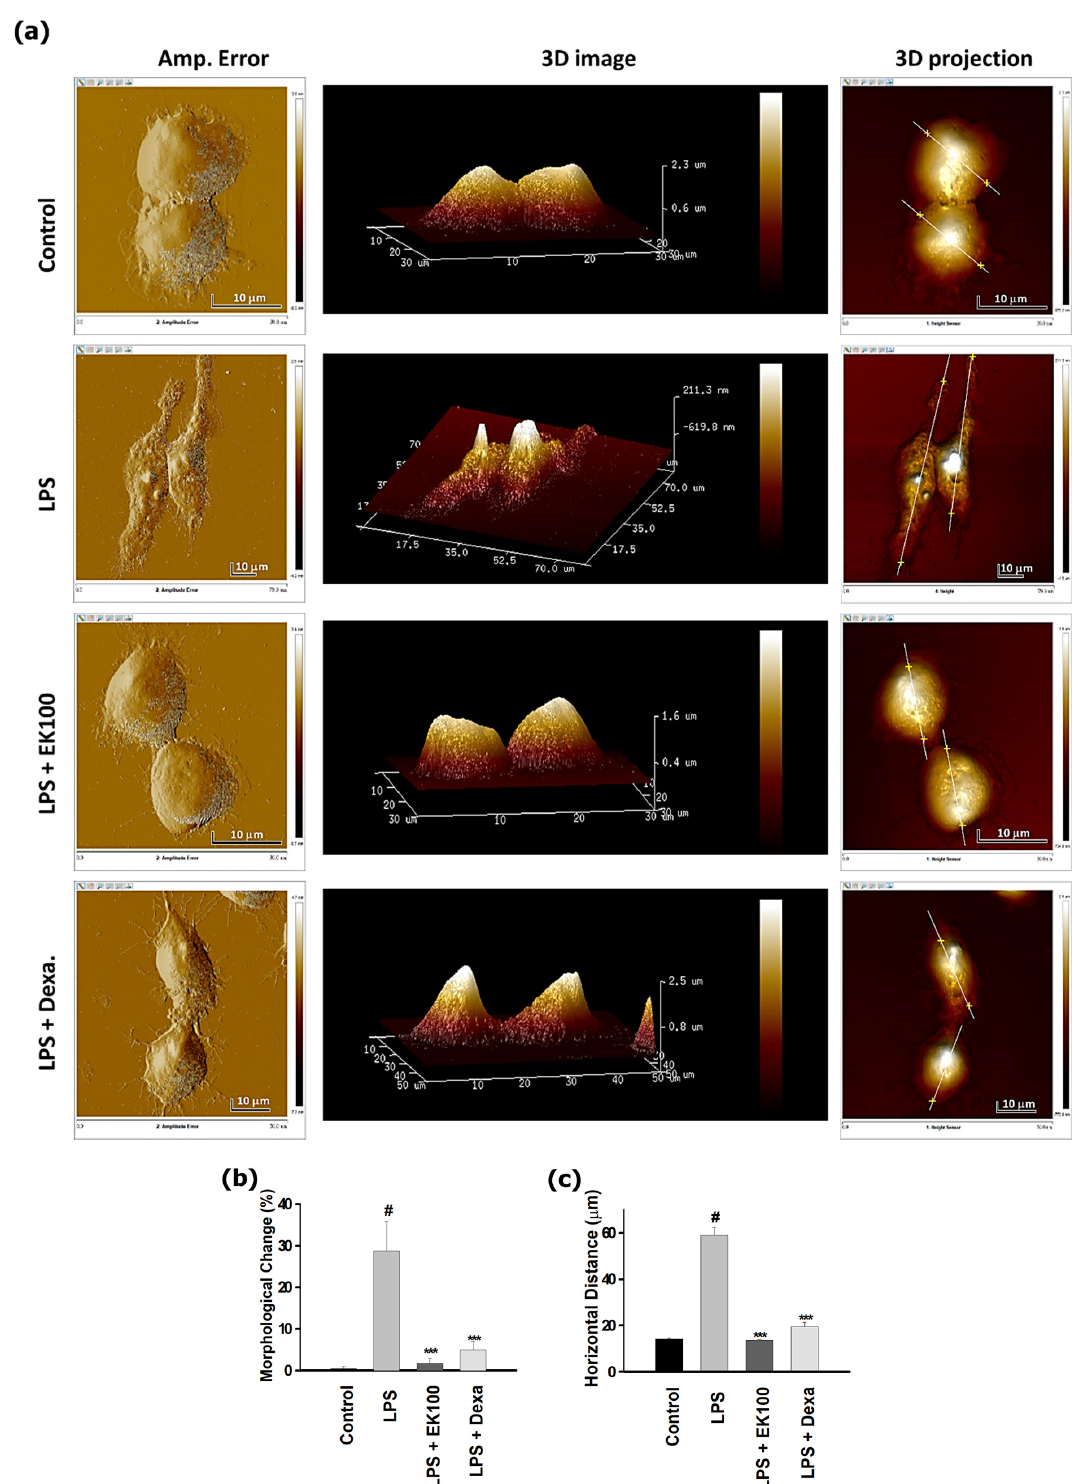
Figure 2. EK100 prevented the morphological change in LPS-stimulated RAW 264.7 cells. ( a ) Cells were treated with 80 µM EK100 or Dexa (2 µM) for 1 h and stimulated with 100 ng/mL LPS for 24 h. The dendritic transformation assay and surface ultrastructural morphological change by AFM assay, including amplitude error, three-dimensional (3D) images, 3D projection, and horizontal distances as designated and described in Materials and Methods. Those analysis data from AFM assay of the ratio of morphological change ( b ) and the horizontal distance ( c ) were analyzed using NanoScope analysis software. All data calculated in the cells were presented as the mean ± SEM of three independent experiments ( n = 3). # p < 0.05 compared with the control group and *** p < 0.001 as compared with LPS alone